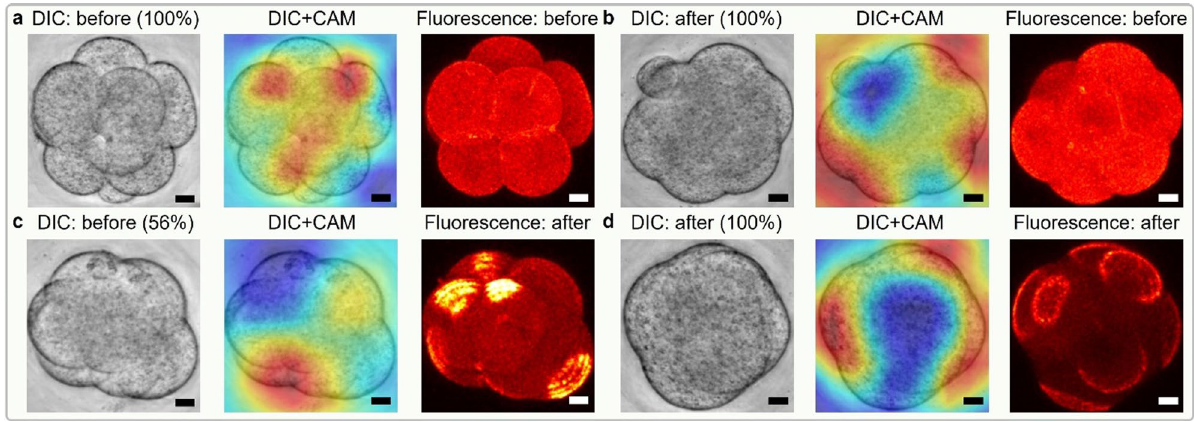
Figure 4. Visualization of the decision-making by the ensemble deep learning model. Heat maps obtained by the class activation mapping (CAM) technique highlight how the ensemble deep learning model attends the discriminative regions in the testing frame when giving the predicted class label. The red regions indicate positive focus of the model (in alignment with the predicted label) and the blue regions negative focus (in opposition to the predicted label). ( a – d ) correspond to four cases in confusion matrix, true negatives (TN), false positives (FP), false negative (FN), and true positives (TP), respectively. In each subfigure, from left to right are the testing DIC image, its overlay with the focus heat map, and its corresponding fluorescence channel image. On top of the test DIC image is the predicted label of the ensemble DL model with its confidence (from 0 to 100%). On top of the fluorescence image is the annotated label by the expert. All the heat maps show that our DL model either attends to the individual blastomeres or the inter-blastomere angles. For example, TP heat map d focuses on the truly polarized blastomeres. At a certain time-point, some blastomeres have started polarization but the others have not, as shown in the FN case ( c ). This issue resulted in the DL model making a Type II error with low confidence in the case given. Scale bar = 20